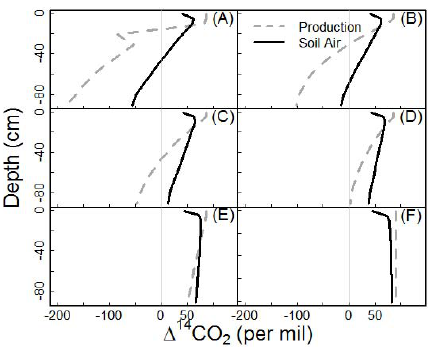
Fig. 10. Comparison of production and soil air 14 CO 2 profiles from dynamic simulations of 1-D